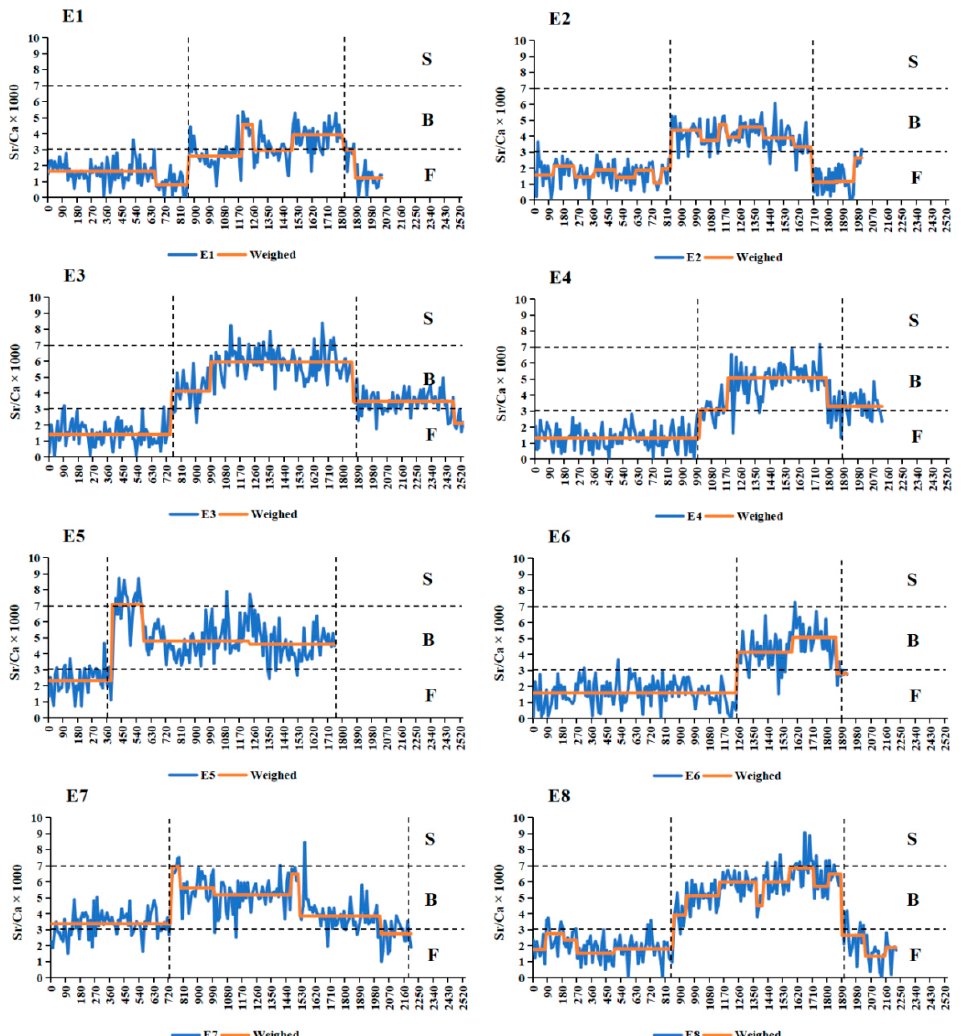
Figure 4. Fluctuation in otolith Sr/Ca ratios along line transects from the core (0 μ m) to the edge in the sagittal plane of the otoliths of different Coilia nasus groups along Yangtze River estuary. Orange solid line represents the Sr/Ca ratios after trend conversion; blue solid lines represent actual Sr/Ca ratios. S: seawater, B: brackish water, F: fresh water.